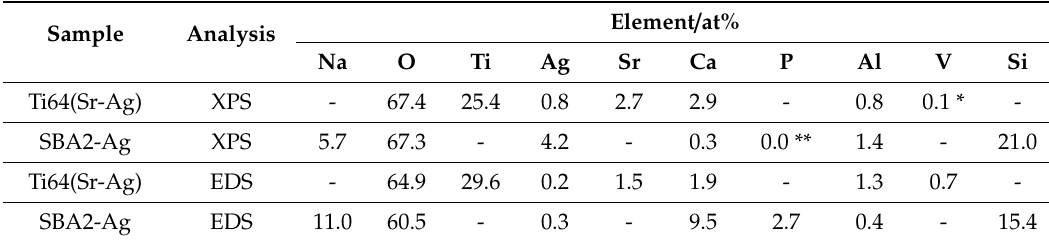
Table 1. X-ray photoelectron spectroscopy (XPS) and SEM-EDS analysis obtained on the top surfaces of Ti64(Sr + Ag) and